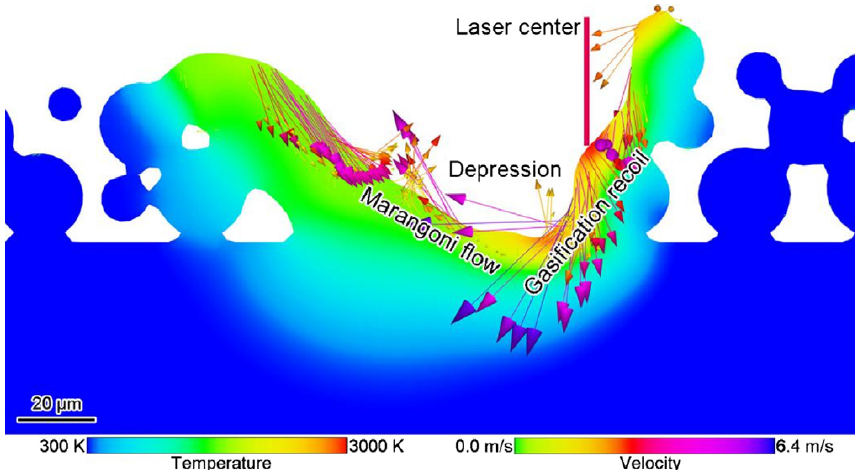
Figure 11. Melt pool dynamics comprising Marangoni effect, gasification recoil